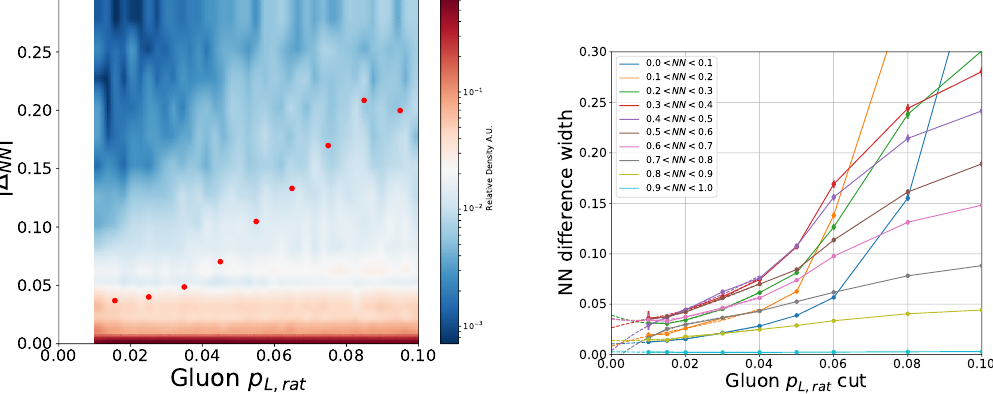
Figure 7 . Left panel: di(cid:11)erence in CNN output between merged and unmerged events, j (cid:1) NN j , as a function of the longitudinal momentum ratio de(cid:12)ned in eq. (3.2). Red dots show the width of the j (cid:1) NN j distribution. Background colors indicate the relative density of events for given longitudinal momentum ratio. Right panel: j (cid:1) NN j width as a function of longitudinal momentum ratio, binned in 10 NN output intervals. The lines indicate an interpolating curve (third-order polynomial) (cid:12)t to the data in each NN output